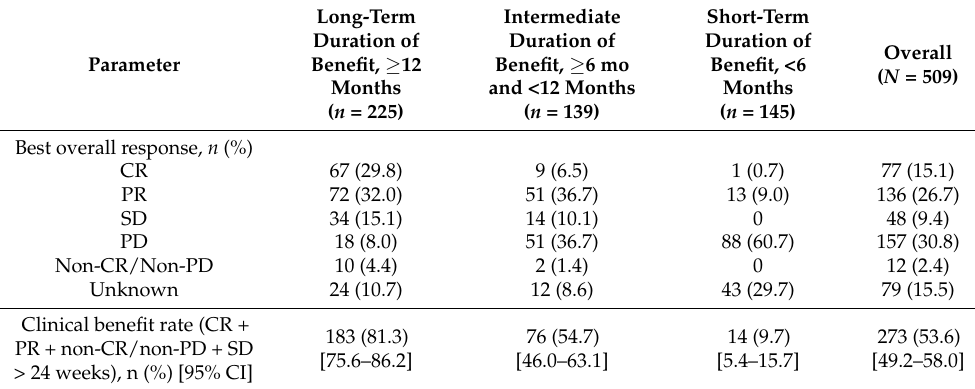
Table 5. Best overall response rate and clinical benefit